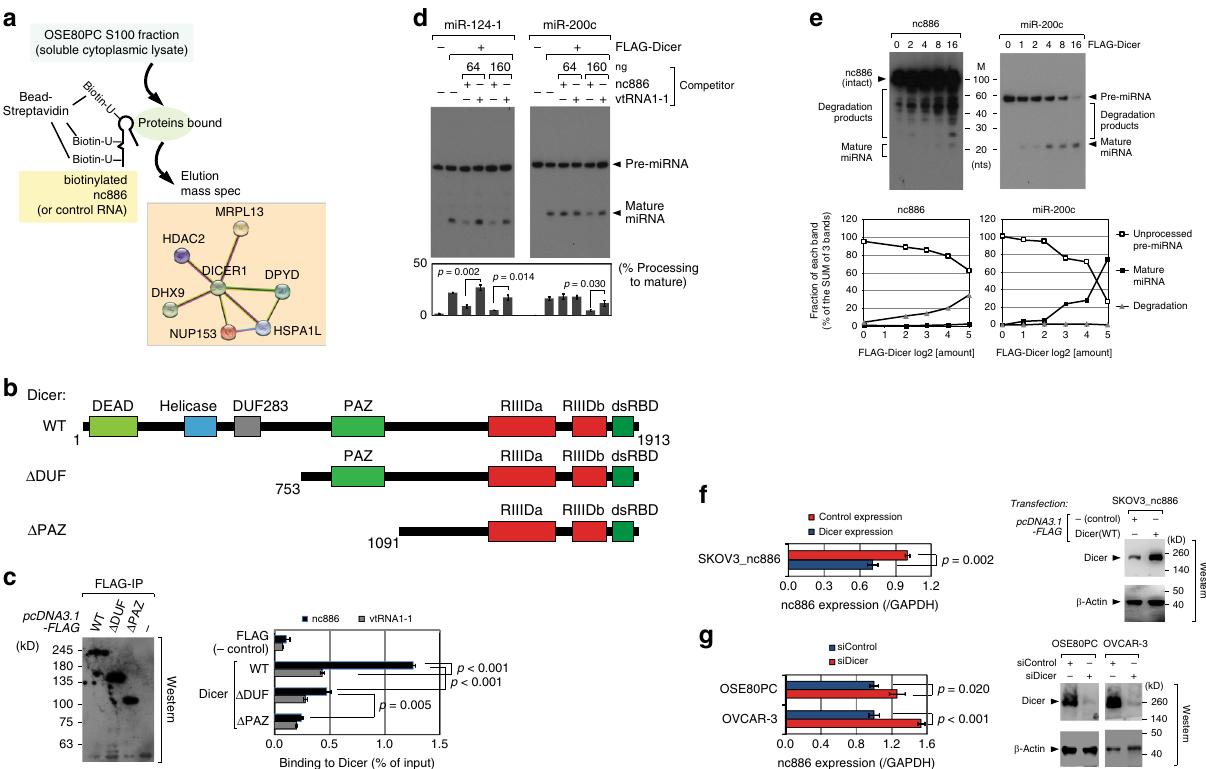
Fig. 5 nc886 is a pseudo-substrate of Dicer and inhibits miRNA maturation. a A schematic diagram for the identi fi cation of nc886-interacting proteins. Dicer and its known interactor proteins are shown in a STRING ™ protein – protein interaction network (https://string-db.org/). The complete list of our mass spectrometry data is shown in Supplementary Data File 7. b Dicer domains and truncated mutants 57 . c Western blot (left panel) and nc886-binding assays (right panel). Plasmids for WT or mutant Dicers ( “ pcDNA3.1-FLAG-Dicer- ” series in Supplementary Table 4) or pcDNA3.1-FLAG vector were transfected into 293T cells. After FLAG-IP, a minor portion of beads was resuspended in SDS-PAGE gel loading buffer and boiled for 2 min to elute the bound proteins which were detected by FLAG western blot (with the anti-FLAG antibody diluted to 1:2000). The remaining major portion was used for binding assays in which % input RNA was calculated from 2 - Δ Ct values. d In vitro processing assays with FLAG-Dicer (WT) which was puri fi ed by FLAG-IP. Maturation of indicated pre-miRNAs was visualized by northern hybridization. Indicated amounts of competitors (unlabeled nc886 or vtRNA1-1) were added to processing reactions. Processed mature miRNA bands as well as unprocessed pre-miRNA bands were quanti fi ed to calculate % of processing [ = mature miRNA / (mature miRNA + pre-miRNA)] that is displayed on the bottom. Each bar in the graph is aligned with the corresponding band. e In vitro processing reactions of nc886 and pre-miR-200c with titrating amounts of FLAG-Dicer. Pre-miRNAs, mature miRNAs, and degradation products were quanti fi ed and plotted (bottom panels). f qRT-PCR measurement (left panel) of nc886 from SKOV3_nc886 cells transfected with pcDNA3.1-FLAG-Dicer (WT). Cells were harvested at 24 h post transfection. Western blot (right panel) detecting Dicer with anti-Dicer antibody. g qRT-PCR of nc886 (left panel) and western blot of Dicer (right panel) at 48 h upon transfection of siRNA against